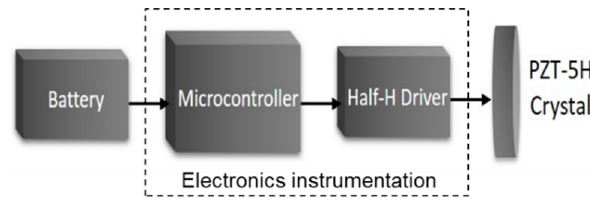
Figure 5. Block diagram of the PPM signal generator design used as a transmitter.